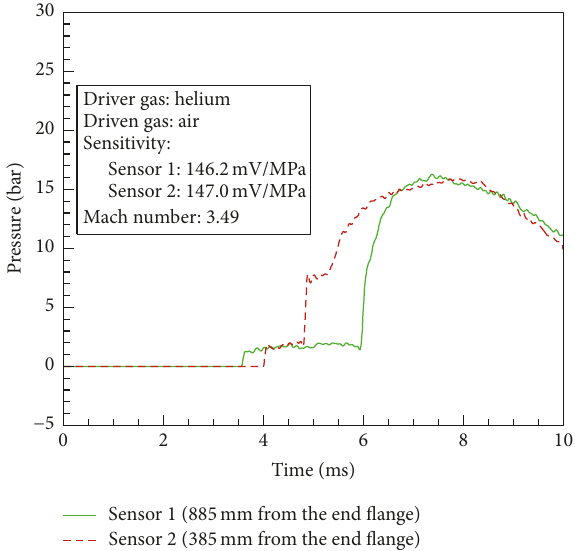
Figure 6: Pressure signal acquired in the shock tube using helium as the driver gas.